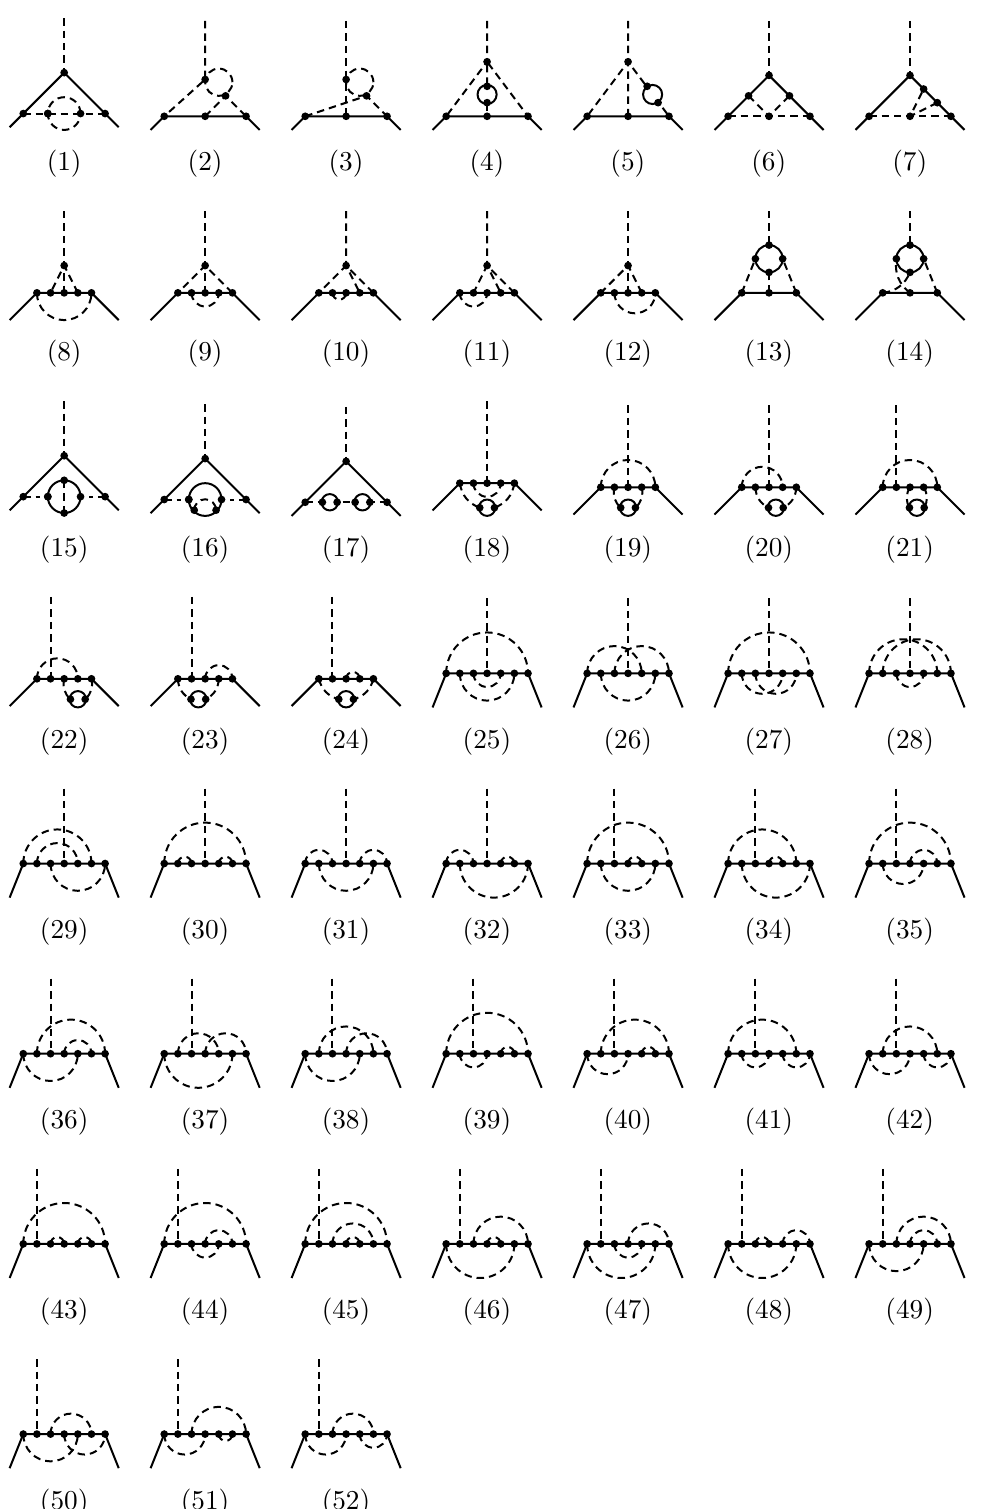
Figure 3 . Yukawa proper vertex diagrams at three-loop order, including scalar (dashed lines) and fermionic propagators (solid